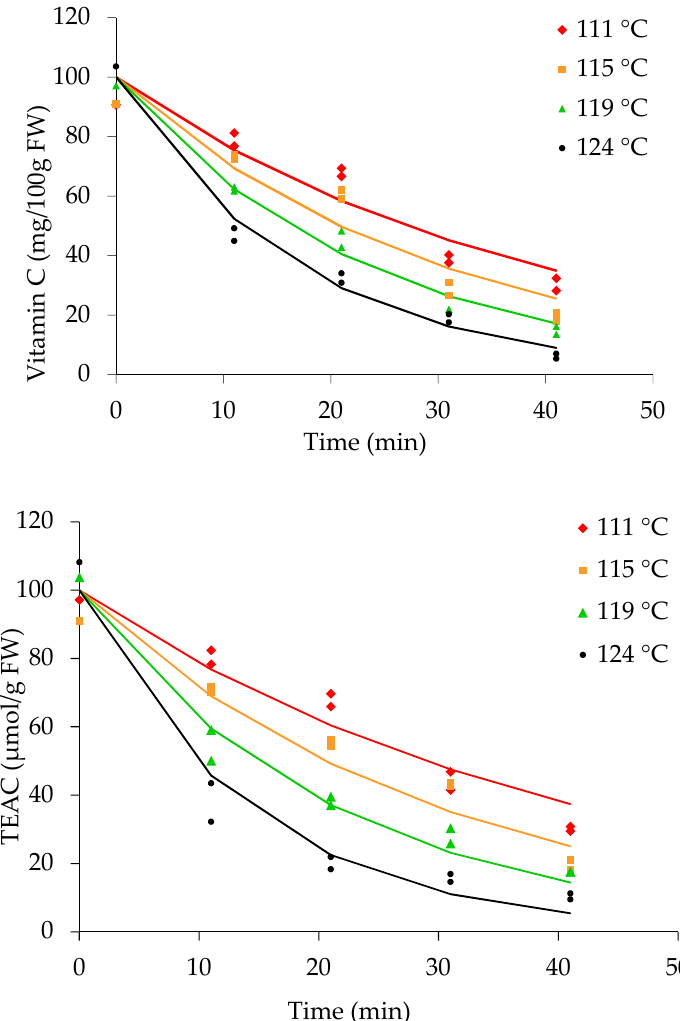
Figure 4. Percentages of vitamin C and TEAC in pineapple pieces expressed as percentages of the original content in initial fruit during canning at different temperatures. Lines are fitted to a model describing first-order degradation using Equations (1) and (2).